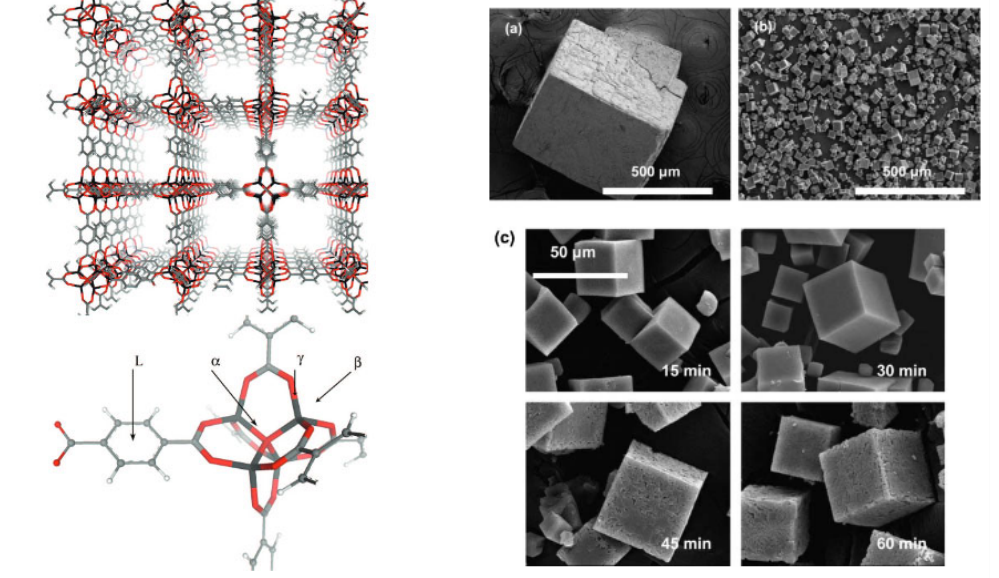
Figure 1. ( Left ): Crystallographic view of MOF-5; ( Right ): SEM images of MOF-5 crystals synthesised using ( a ) solvothermal method, ( b ) microwave, and ( c ) degradation of MOF crystals as a result of microwave irradiation for 15, 30, 45, and 60 min. Reproduced with permission from [32 , 35] .